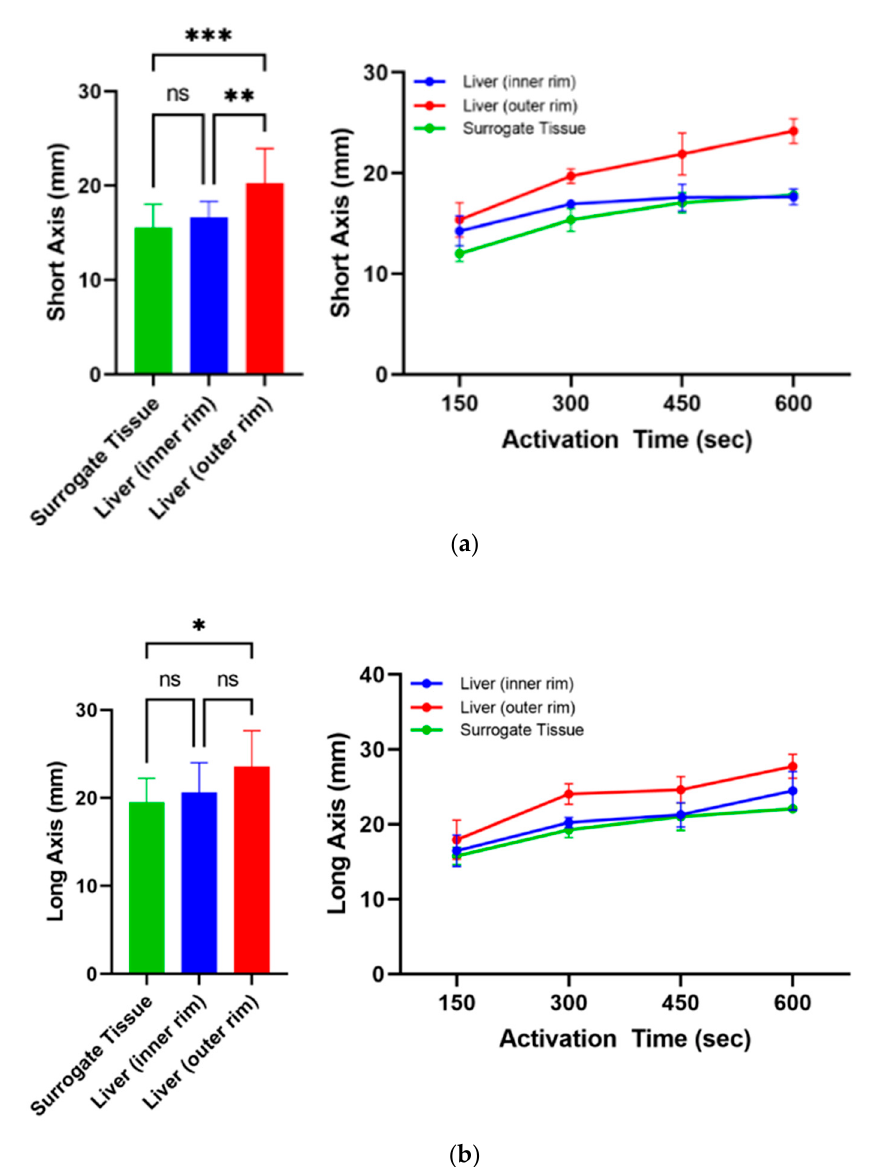
Figure 4. Comparison of ablation growth during RFA in surrogate tissue with 0.096% sodium chloride (green) to the inner (blue) and outer (red) rim of bovine liver as a mean over all ablation points (left) and as a function of RF activation time (right); ( a ) short axis and ( b ) long axis. * p ≤ 0.05; ** p ≤ 0.01; *** p ≤ 0.001; ns: p > 0.05.